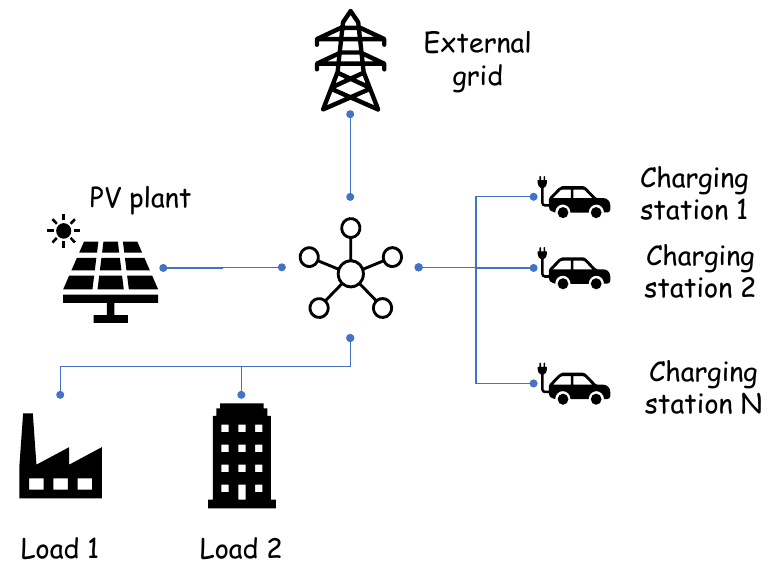
Figure 1. Micro-grid